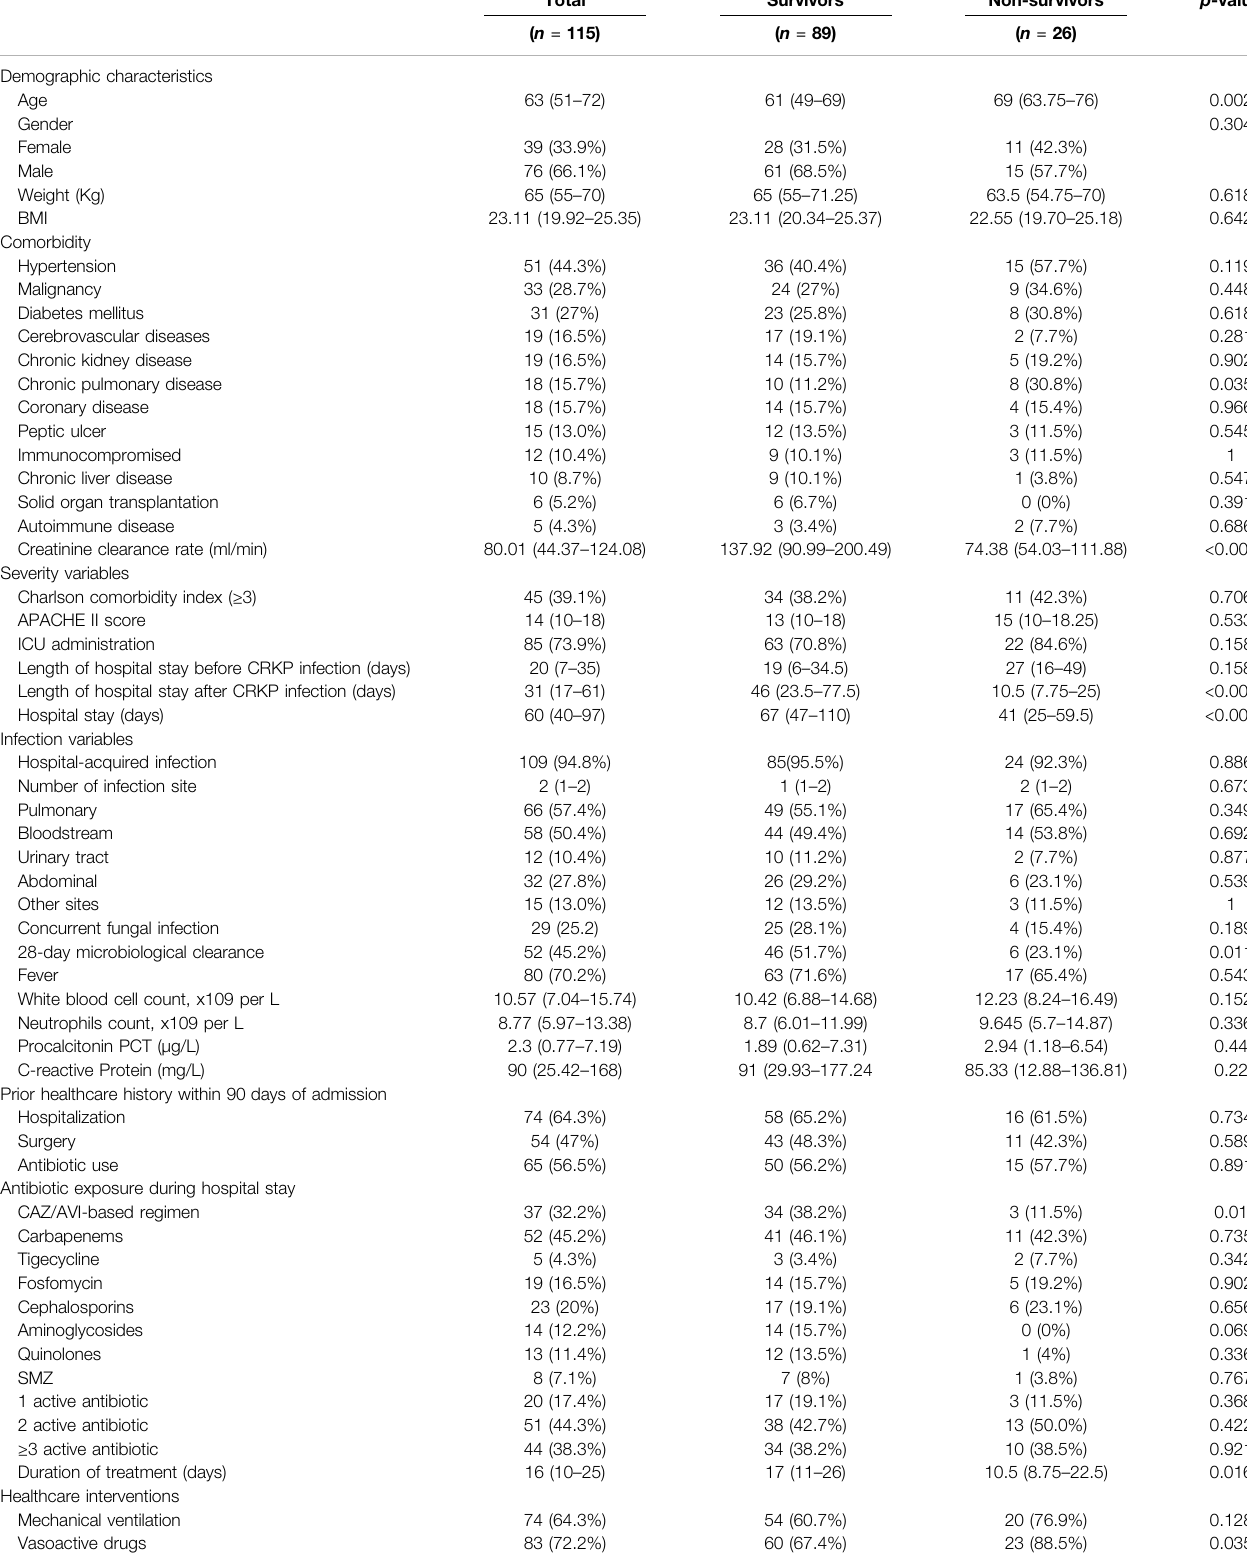
TABLE 5 | Univariate analysis of factors associated with 28-Day mortality in the 115 patients with CRKP